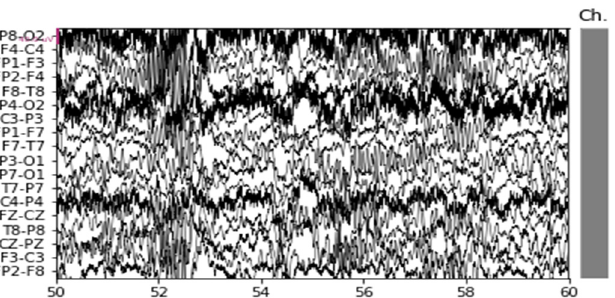
Figure 1. Sample of CHB-MIT dataset represented by parallel readings from electrodes placed on a patient’s scalp.